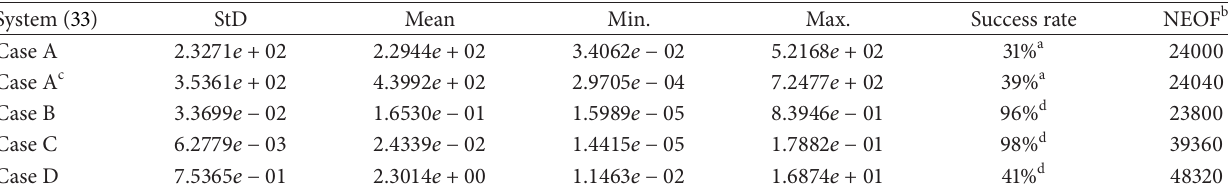
Table 5: Simulation results for system (33).